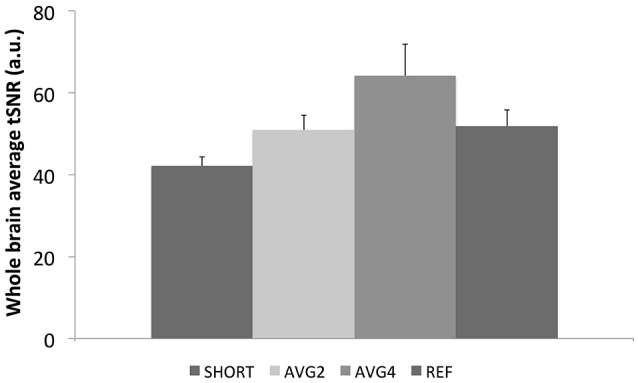
Whole-brain average tSNR values for each EPI sequence. SHORT, TR = 700 ms; AVG2, TReffective = 1400 ms; AVG4, TReffective = 2800 ms; REF, TR = 1440 ms.